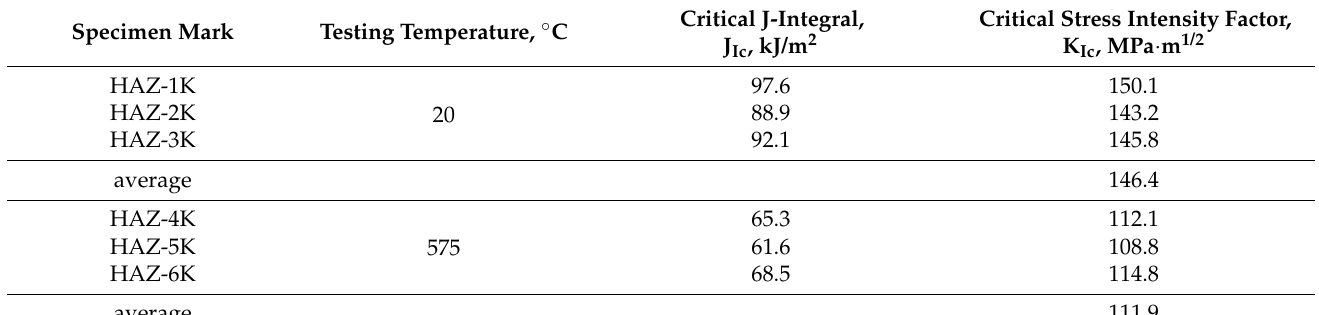
Table 12. K Ic values obtained via J Ic for SA 387 Gr. 91—HAZ.